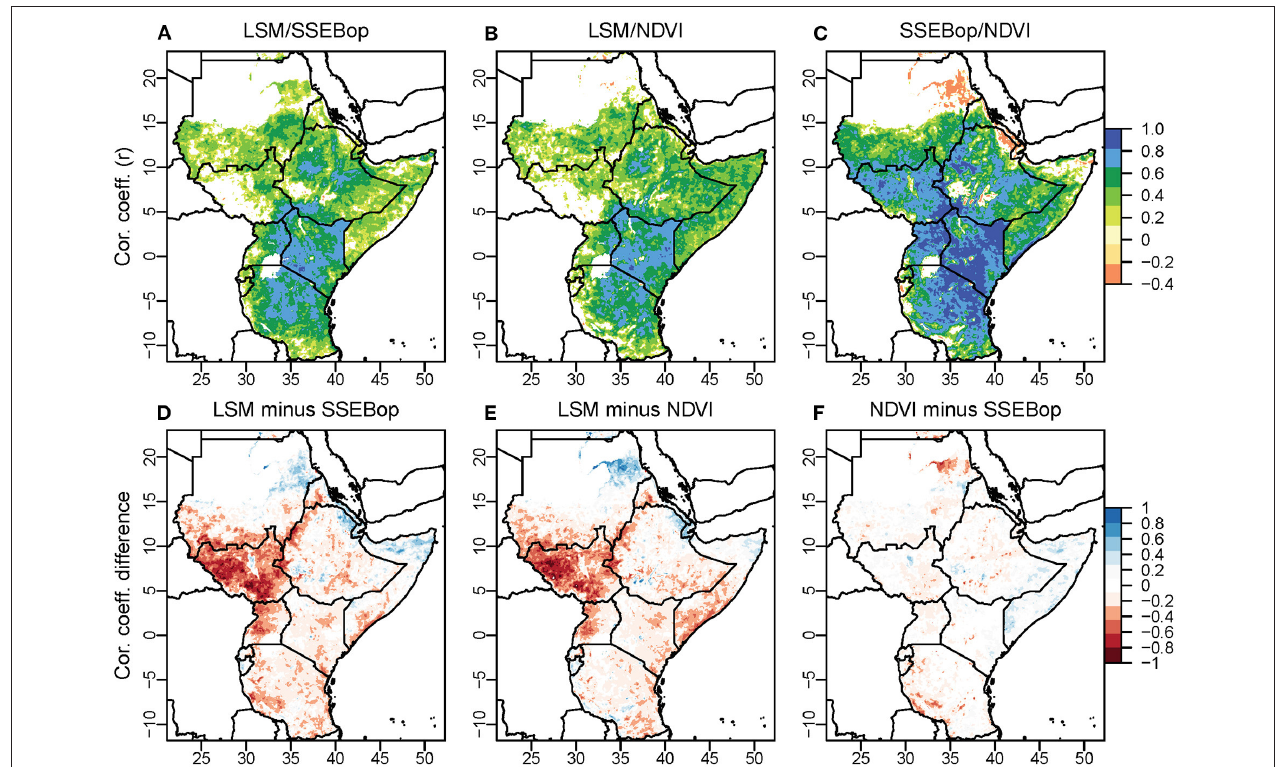
FIGURE 5 | Time series anomaly cross-correlation coefficient calculated over the wetter half of the year for 2003–2016 for (A) LSM ET/SSEBop ET, (B) LSM ET/NDVI, and (C) SSEBop ET/NDVI. (D) The difference in anomaly cross-correlation where blue (red) shading indicates LSM ET/NDVI correlation is greater (less) than NDVI/SSEBop ET correlation. (E) The difference in anomaly cross-correlation where blue (red) shading indicates LSM ET/SSEBop ET correlation is greater (less) than NDVI/SSEBop ET correlation. Only pixels that exhibit a statistically significant correlation at 90% confidence interval are shown ( p < 0.1). (F) The difference in anomaly cross-correlation where blue (red) shading indicates LSM ET/SSEBop ET correlation is greater (less) than LSM ET/NDVI